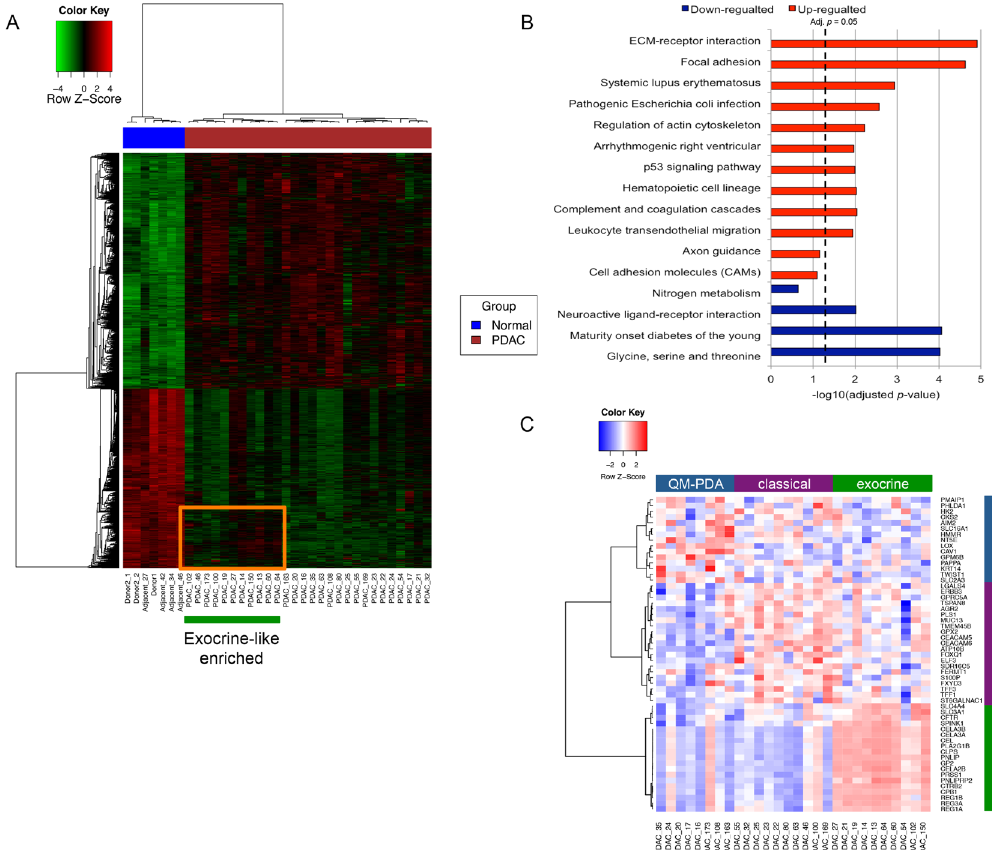
Figure 1. Differentially expressed protein-coding genes in PDAC. ( A ) Heatmap of the 1,887 differentially expressed transcript clusters in PDAC. The heatmap represents relative over- (red) and under-expressed (green) genes. The covariates at the top represent tumour (red) and normal (blue) samples. A subgroup of 11 PDAC samples is indicated by the orange box, determined by the exocrine-like gene signature by Collisson et al . with higher expression in a cluster of 255 transcripts than other PDAC samples. ( B ) KEGG pathway enrichment test for significantly up- and down-regulated genes in PDAC. The BH adjusted p -values were used (x-axis). ( C ) Heatmap and sample clustering based on the Collisson signature dividing samples into three molecular